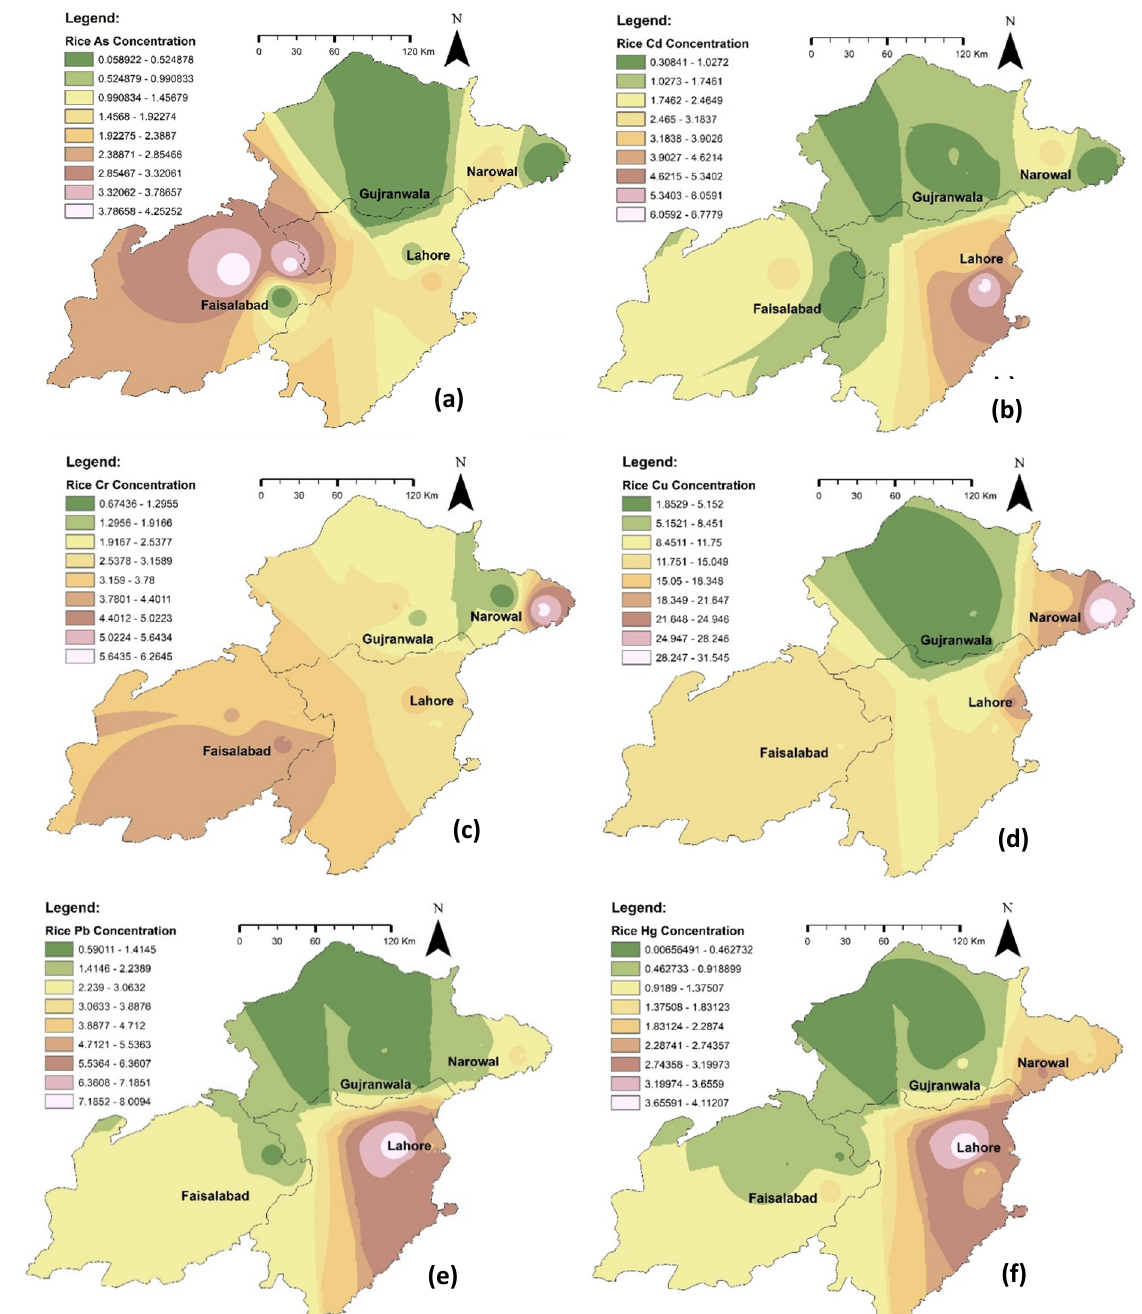
Figure 5. Spatial distribution maps of various metal and metalloid concentration in rice samples. Variation in color indicates the levels of metal and metalloid (mg kg − 1 ) concentrations in fragrant rice samples (super basmati) from sampling points; ( a ) arsenic contents; ( b ) cadmium contents; ( c ) chromium contents; ( d ) copper contents; ( e ) lead contents; ( f ) mercury contents